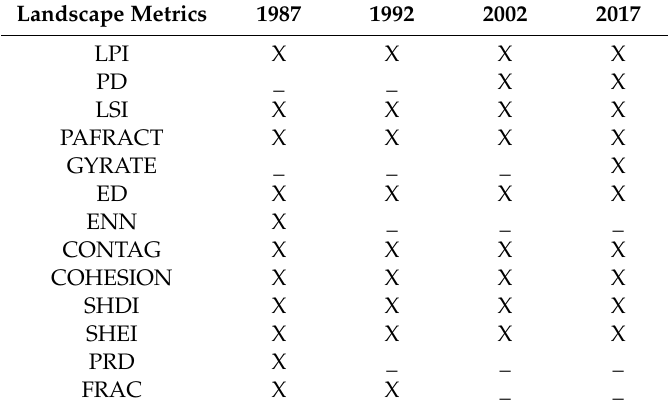
Table 1. Discriminant analysis landscape metrics (X shows landscape metrics that are significant for certain time intervals when forming